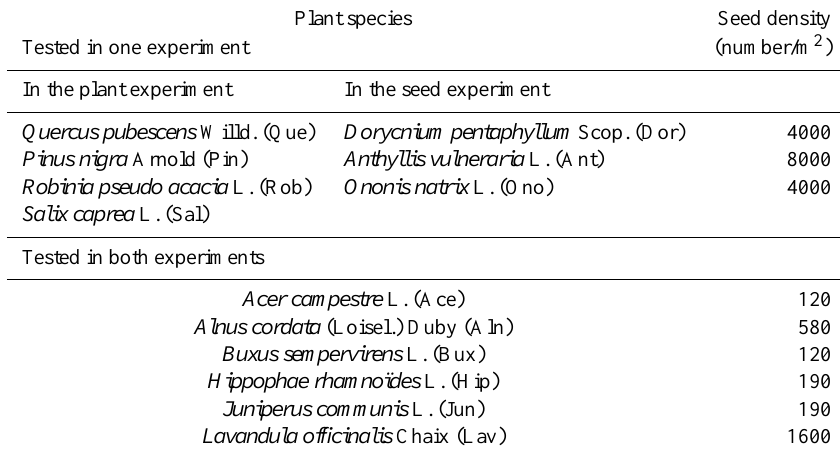
Table 1. List of species tested in the two experiments and seed density (for species tested in the seed experiment). Plant species Seed density Tested in one experiment (number/m 2 ) In the plant experiment In the seed experiment Quercus pubescens Willd. (Que) Dorycnium pentaphyllum Scop. (Dor) 4000 Pinus nigra Arnold (Pin) Anthyllis vulneraria L. (Ant) 8000 Robinia pseudo acacia L. (Rob) Ononis natrix L. (Ono) 4000 Salix caprea L. (Sal) Tested in both experiments Acer campestre L. (Ace) 120 Alnus cordata (Loisel.) Duby (Aln) 580 Buxus sempervirens L. (Bux) 120 Hippophae rhamnoïdes L. (Hip) 190 Juniperus communis L. (Jun) 190 Lavandula officinalis Chaix (Lav)